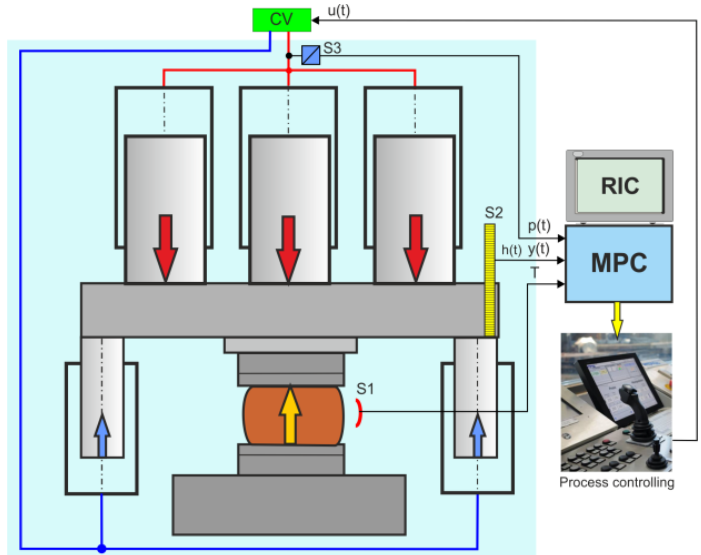
Figure 11. Diagram of the control scheme of the 80 MN hydraulic forging press: S1—infra-red temperature sensor T , S2—position transducer, S3—pressure transducer, CV—control valve, RIC—real-time intelligent control system, MPC—model predictive control.